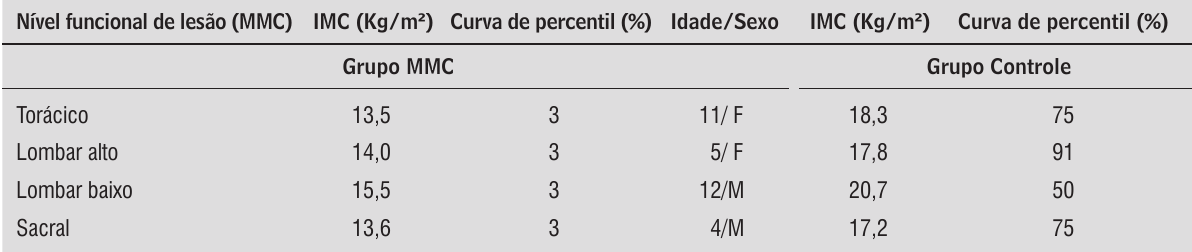
Tabela 1 - Características antropométricas dos grupos de MMC e